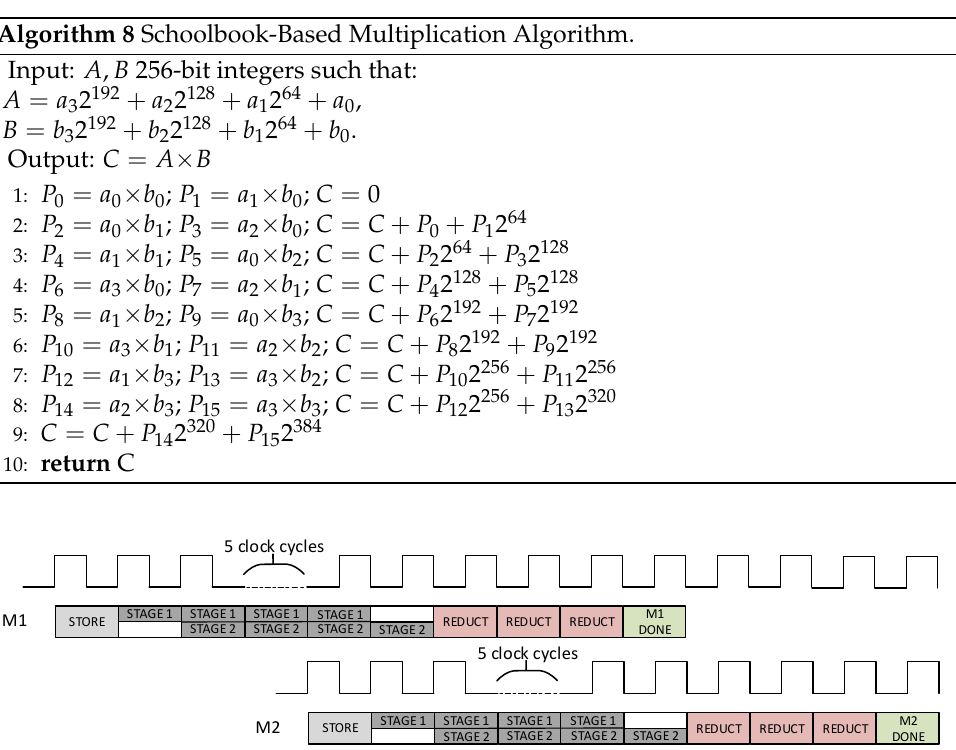
Figure 4. Modular Multiplier Data Timeline for NIST P-256